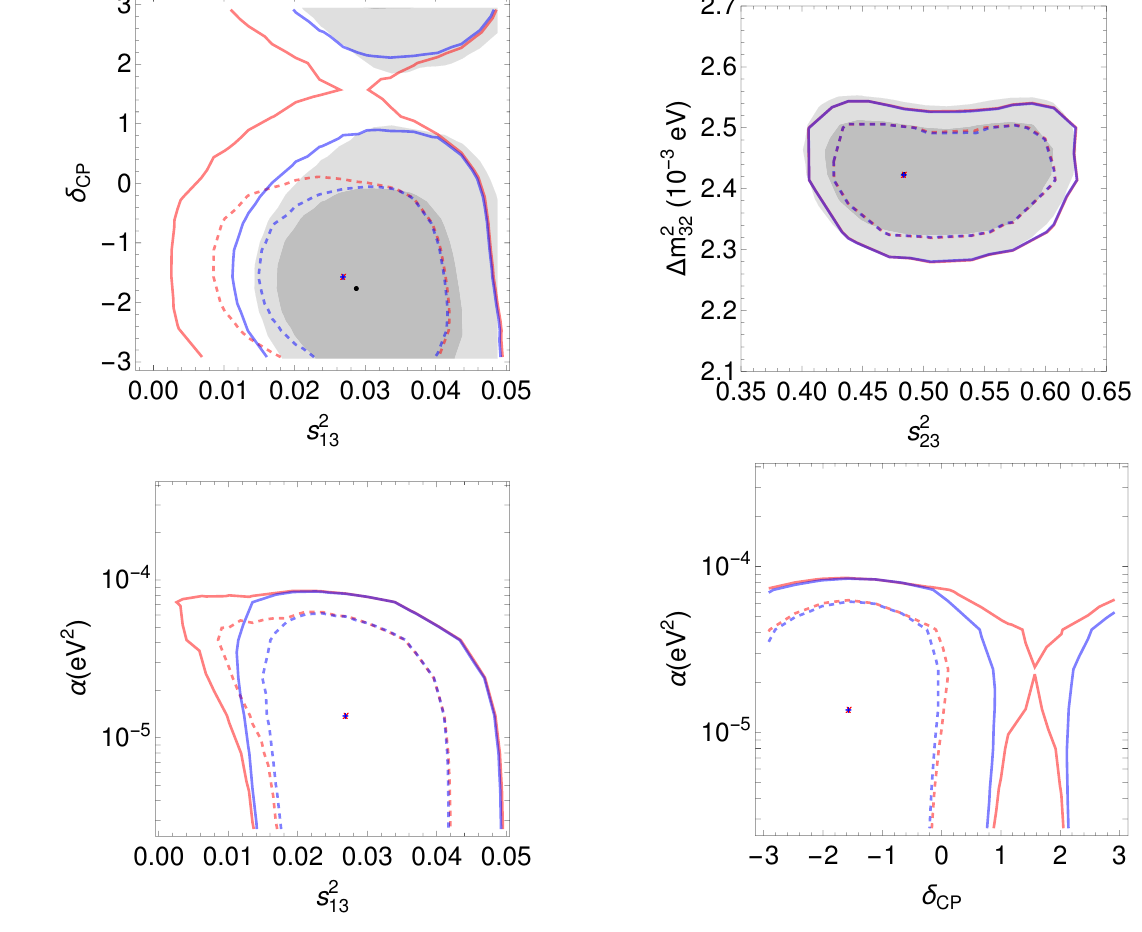
Figure 7 . As in (cid:12)gures 4 and 6, but combining T2K and MINOS data. On the top right panel we show the allowed s 2